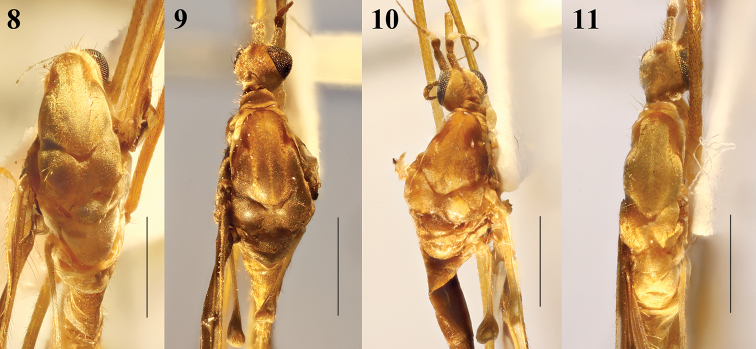
Head and thorax (male). dorsal view. 8Epiphragma (Epiphragma) acuminatum sp. nov. 9Epiphragma (Epiphragma) henanensis sp. nov. 10Epiphragma (Epiphragma) insigne (van der Wulp, 1878) 11Epiphragma (Epiphragma) longitubum sp. nov. Scale bars: 1 mm.